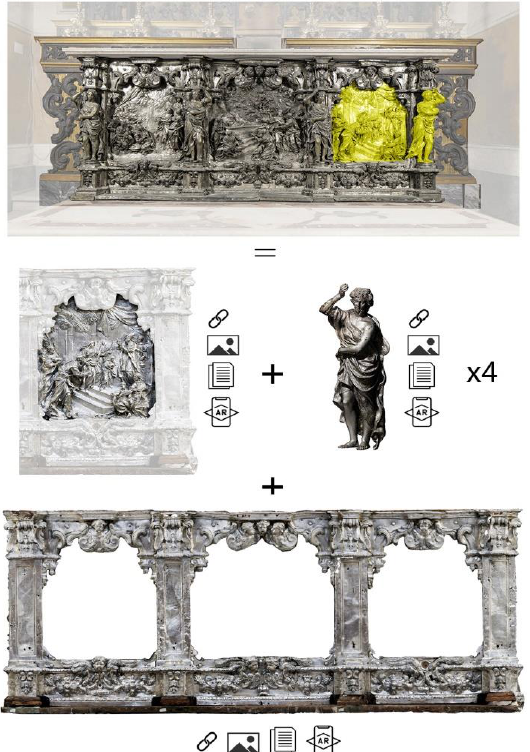
Figure 9 . Frontal semantic decomposition for data storage